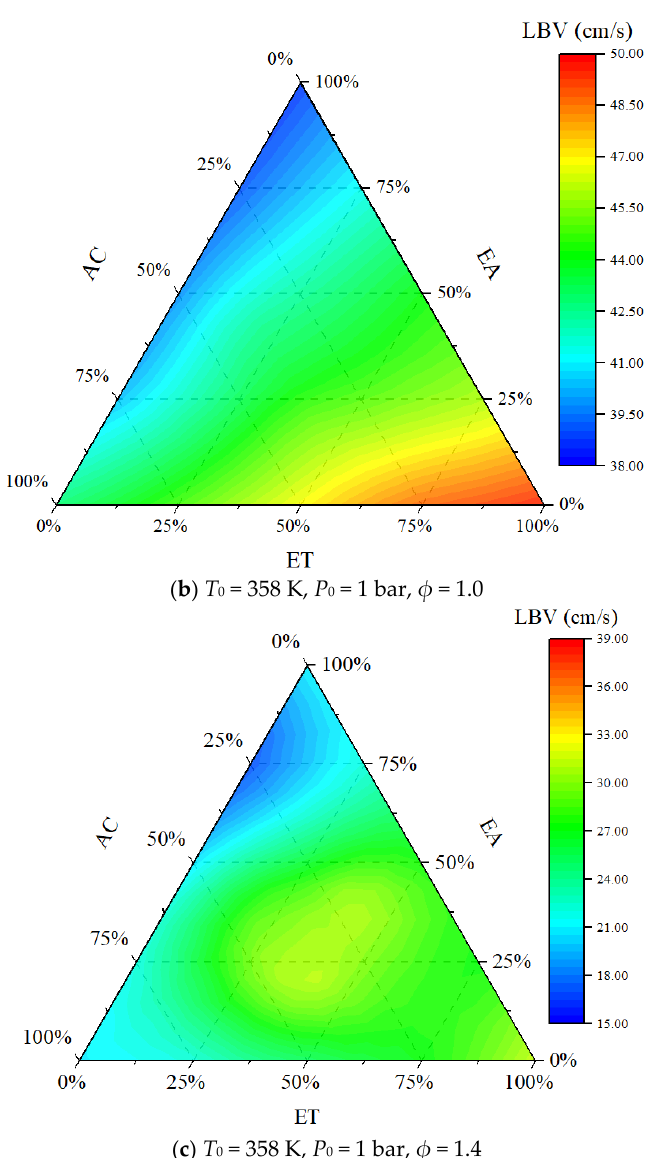
Figure 4. Ternary contour phase diagram of the laminar burning velocity at T 0 = 358 K, P 0 = 1 bar, and ϕ = 0.8, 1.0, and 1.4.